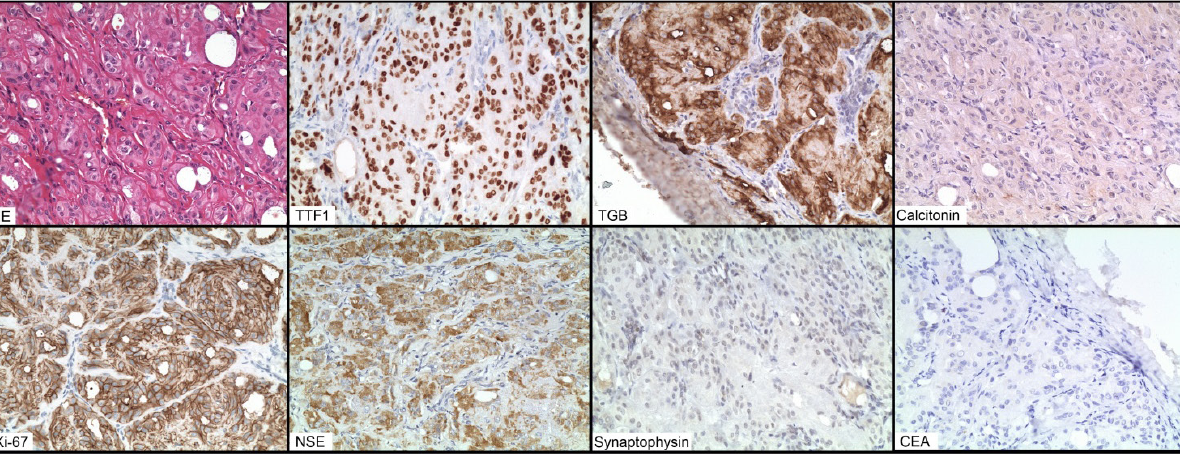
Fig. 4. Immunohistochemistry. TTF1, TGB, NSE – positive. Calcitonin, synaptophysin, CEA – negative. Ki-67 (MIB1) with typital for HTT menbranout positivity. Obj. magnif.